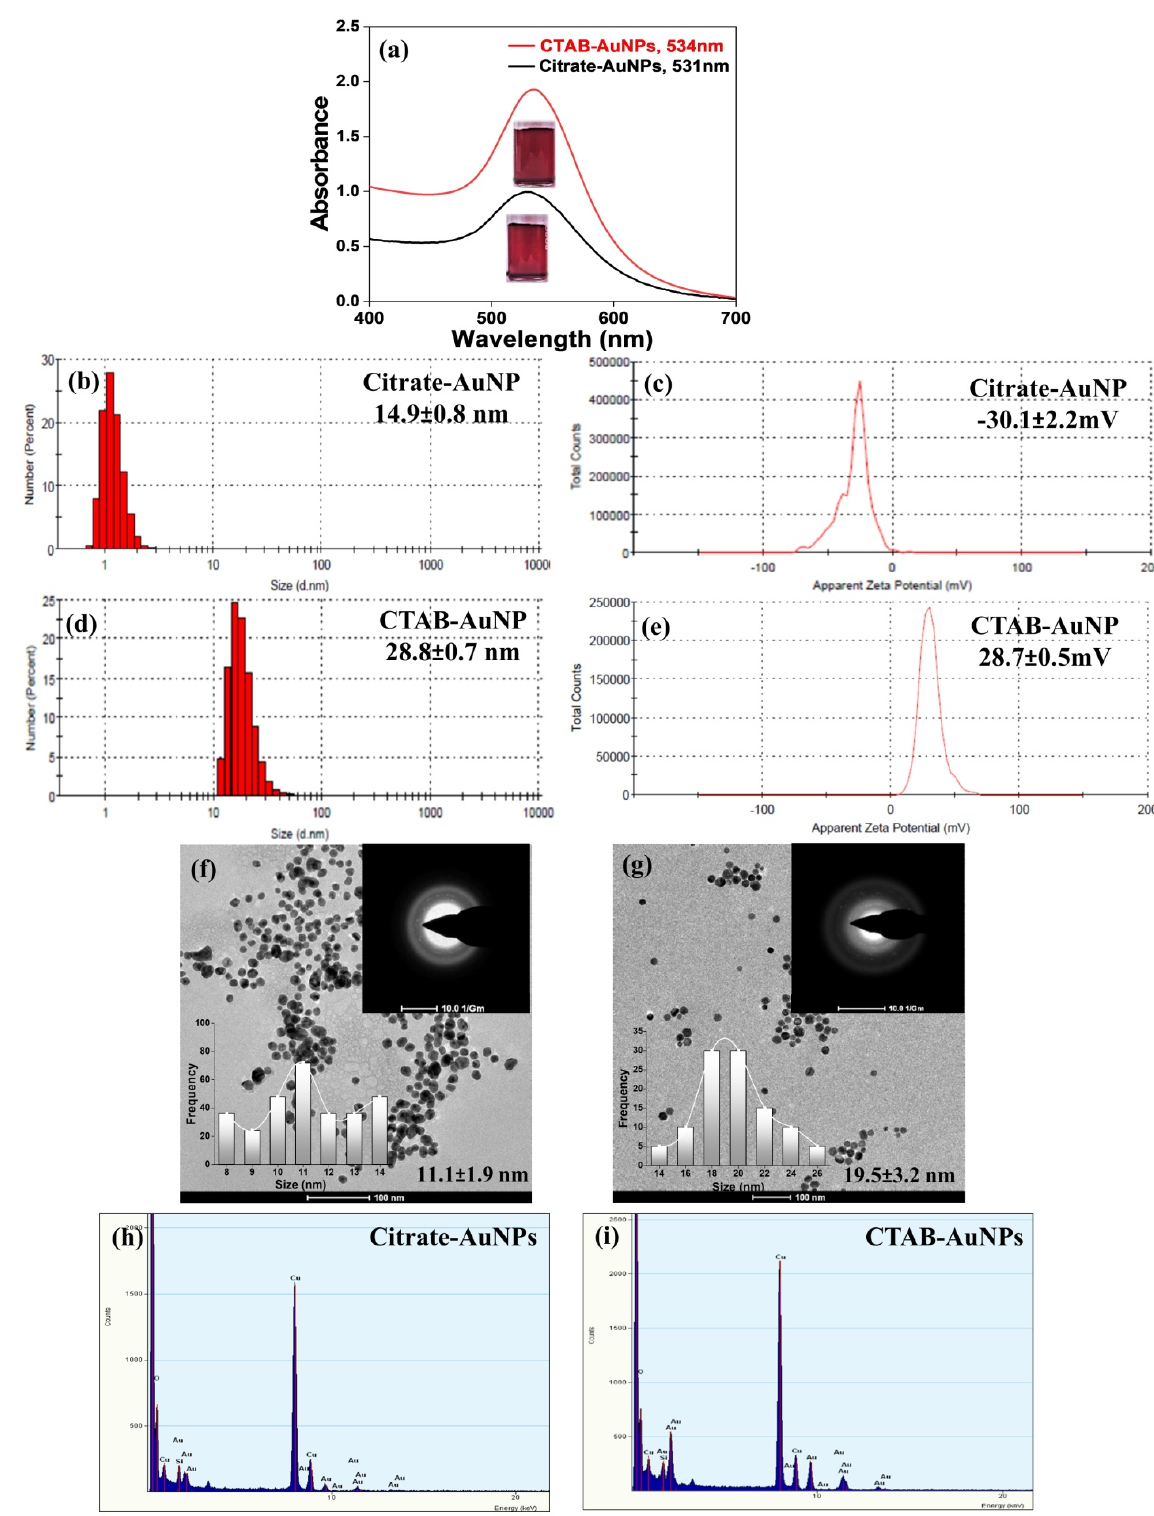
Figure 1. Characterization of the AuNPs. ( a ) UV–Vis absorption spectra of the synthesized citrate- AuNPs and CTAB-AuNPs (insets are the digital photographs of the corresponding AuNPs). ( b , d ) DLS and ( c , e ) zeta potentials of the citrate-AuNPs and CTAB-AuNPs, respectively. ( f , g ) The TEM micro- graphs (top-right insets are the SAED patterns, bottom-left insets are the TEM size distribution of the AuNPs) and ( h , i ) EDAX of the citrate-AuNPs and CTAB-AuNPs,